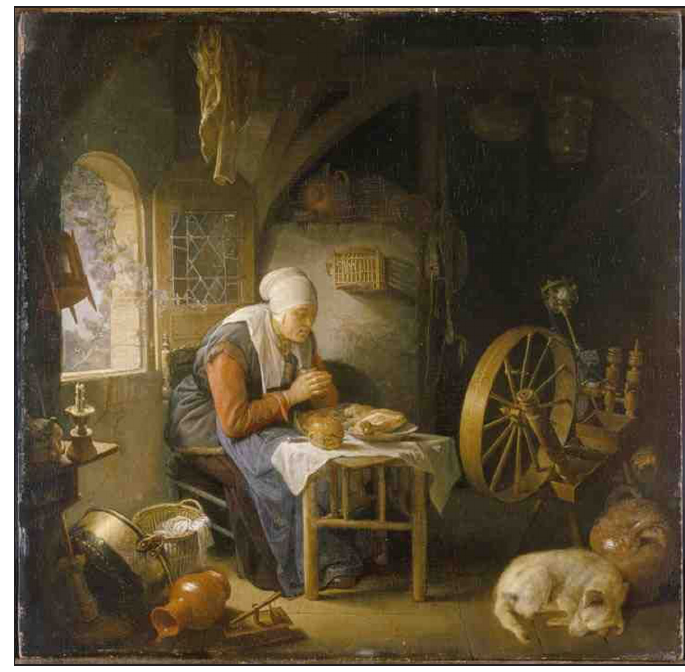
Fig. 2 : Gerard Dou, The Spinner’s Prayer , c. 1645, oak, 27.5 × 28.5 cm,